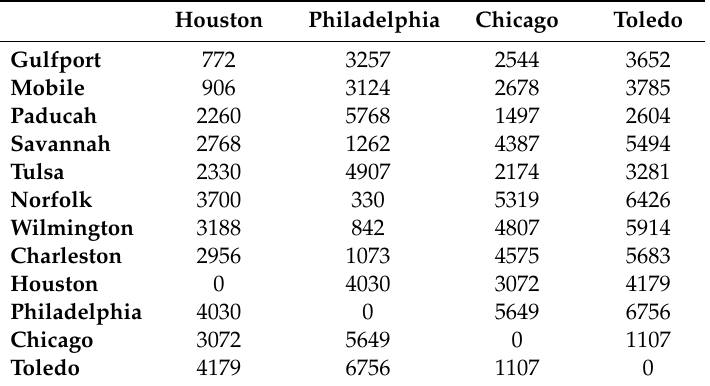
Table A11. Barge distances between Transesterification and Demand locations (km).